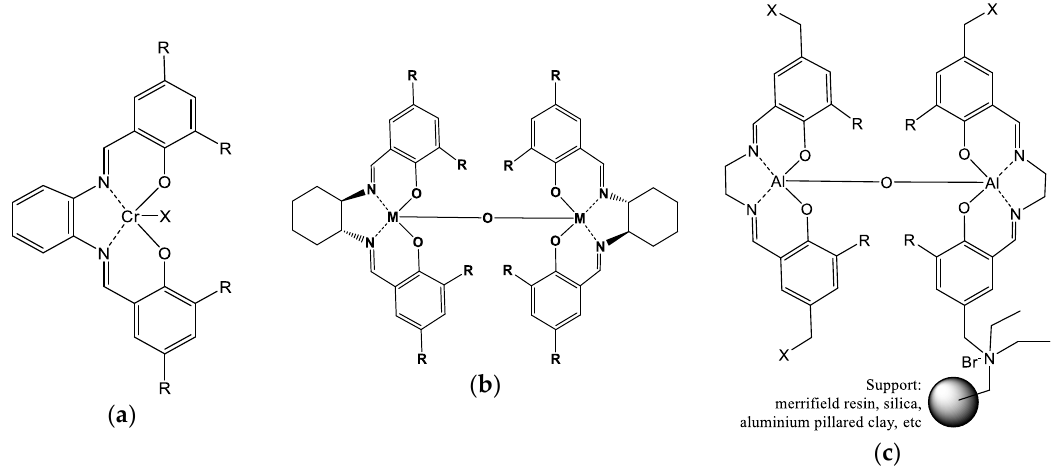
Figure 6. Organometallic salen-based catalysts: ( a ) homogeneous monometallic salen complexes; ( b ) homogeneous bimetallic salen complex; ( c ) heterogeneous bimetallic salen complex supported by various supports.